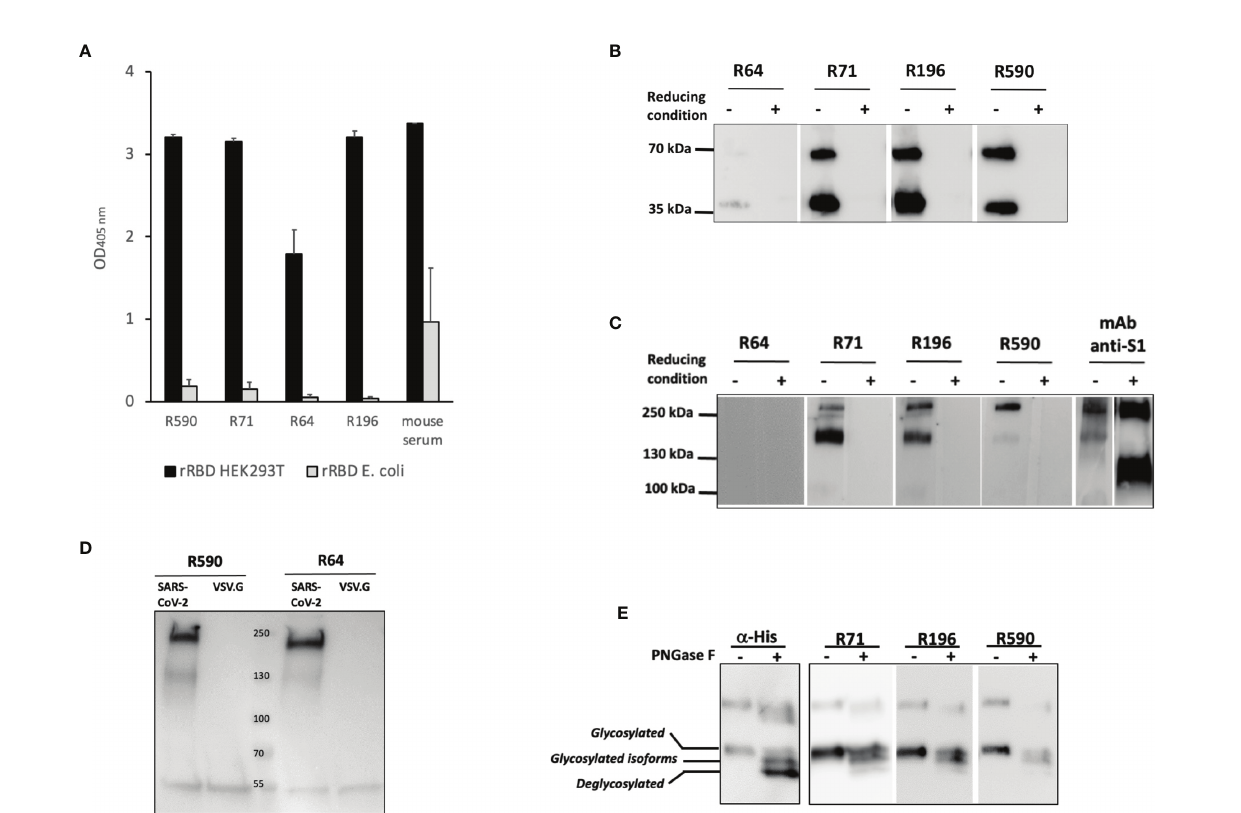
FIGURE 3 | Binding of mAbs to RBD requires disul fi de bonds and glycosylation. (A) Binding of mAbs to rRBD produced in mammalian (RBD HEK) or prokaryotic (RBD E. coli ) expression system evaluated by ELISA. Serum from a mouse immunized with rRBD HEK was used as positive control of antigenicity. Error bars indicate standard deviations of technical duplicates from a representative experiment repeated three times. (B, C) rRBD (B) or VERO E6 cell supernatant containing 1x10 6 SARS-CoV-2 PFU/ml (C) were denatured without (non-reducing condition) or with (reducing condition) b ME and resolved on SDS-PAGE followed by WB using R64, R71, R196 and R590 mAbs. Anti-S1 mAb was used as positive control. (D) HEK293T cell supernatant containing lentiviral vector pseudotyped with pSpike-FurPPC3 (SARS-CoV-2) was incubated with mAbs R590 and R64 conjugated to protein G. Lentiviral vector pseudotyped with VSV.G (VSV.G) was used as negative control. Immunoprecipitation was analyzed by SDS-PAGE followed by WB using anti-S1 mAb. (E) rRBD N-deglycosylation was performed in denatured, non-reducing conditions and revealed using a -His mAb and R71, R196 and R590. The positions of glycosylated, deglycosylated and glycosylated isoforms of rRBD are reported. Each panel from (B – E) shows a representative experiment repeated at least two